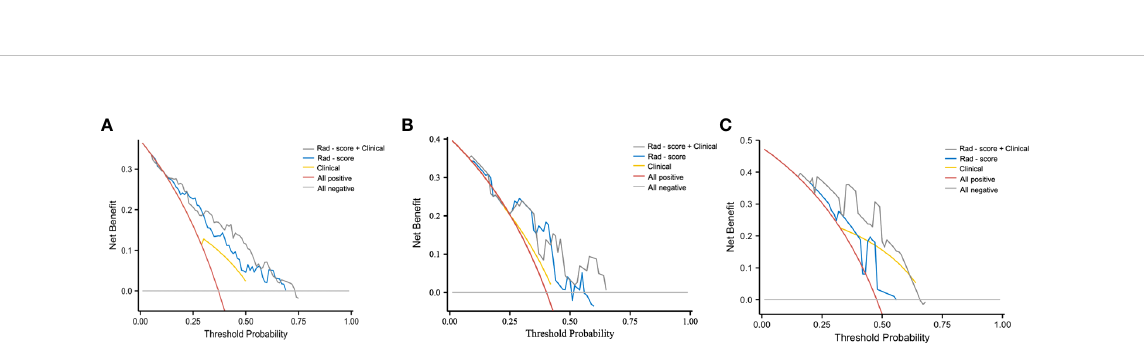
FIGURE 8 DCA curve of clinical use assessment of the radiomic signature and the radiomic nomogram in the training cohort (A) , internal validation cohort (B) , and external validation cohort (C) . The net bene fi t is shown on the y ‐ axis and the threshold probability is shown on the x ‐